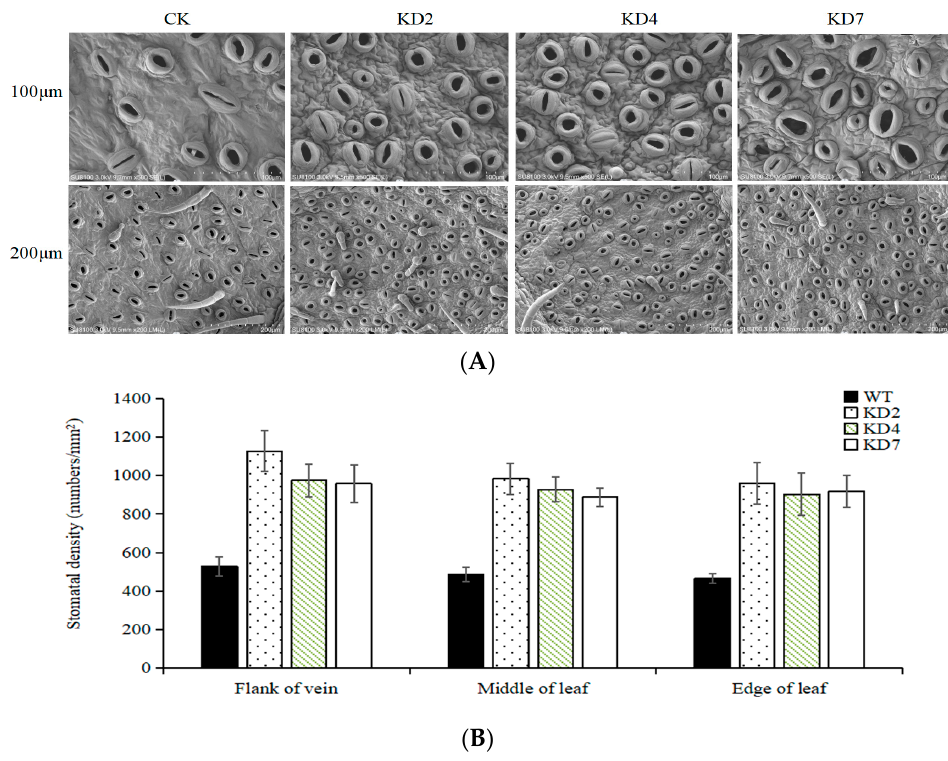
Figure 3. Leaf stomatal density and expression of stomatal development genes in transgenic and WT plants. ( A ) Scanning electron micrograph of the abaxial leaf epidermis. ( B ) Leaf stomatal density for transgenic and WT plants.